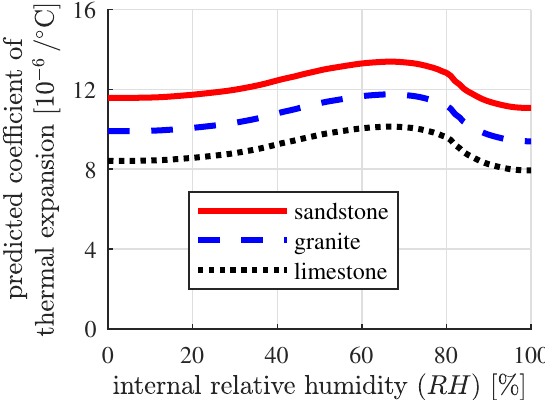
Figure 6. Dependence of the thermal expansion coefficient on the internal relative humidity for concrete, containing sandstone, granite and limestone, respectively, as coarse aggregates, with w / c = 0.40, f cp = 0.30 and with the ratio of the volume fraction of the coarse aggregates over the total volume of aggregates equal to